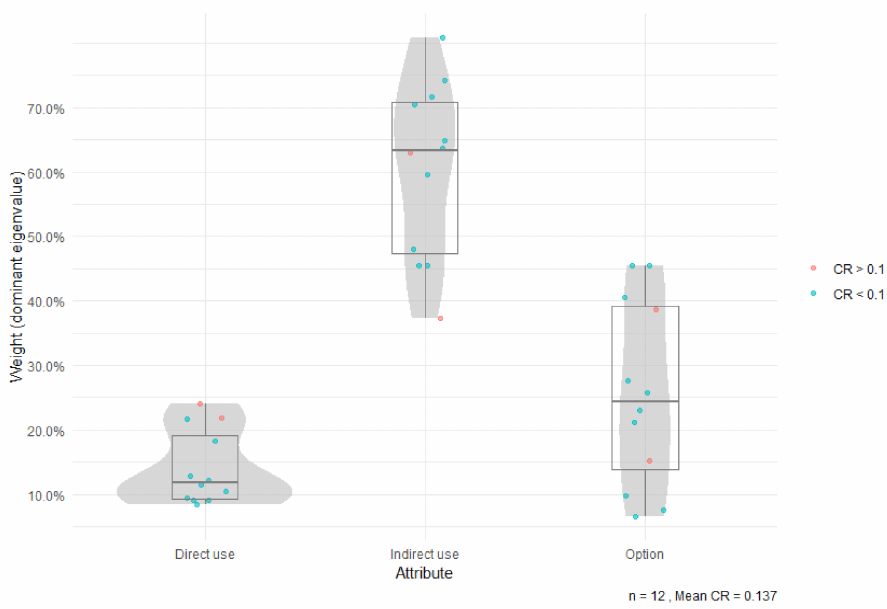
Figure 11. Boxplots of individual priorities and consistency